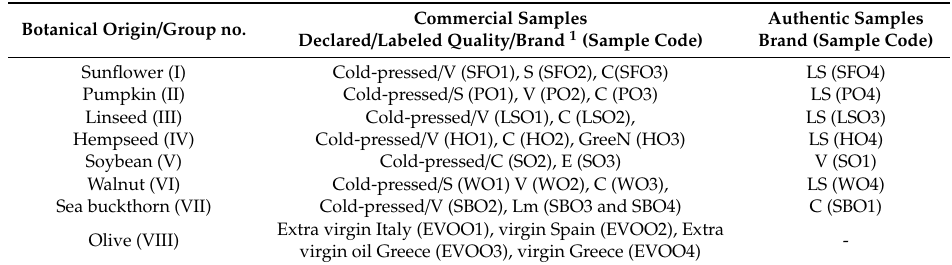
Table 1. The botanical origin, the declared / labeled quality grade, the brand abbreviation and codes which were used in classification